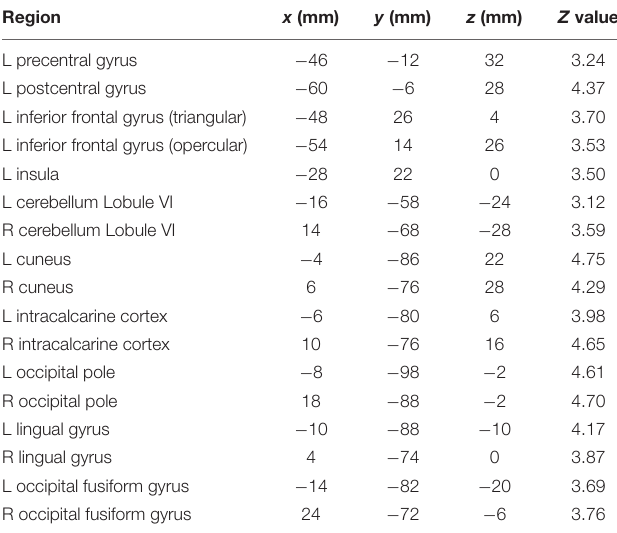
TABLE 1 | Local maxima of brain activity: stereotaxic coordinates in MNI space, Z values, and corresponding brain regions for the contrast English > German speech sound